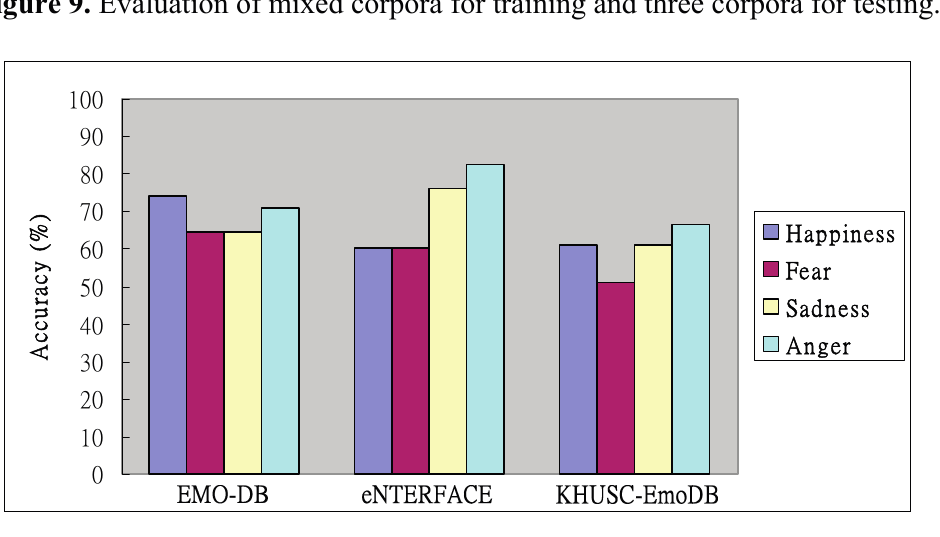
Figure 9. Evaluation of mixed corpora for training and three corpora for